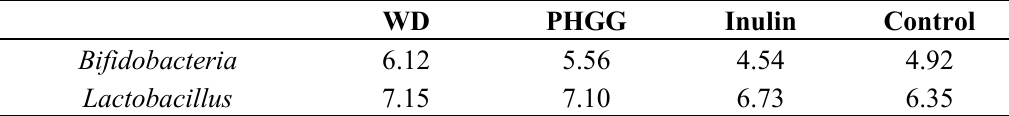
Table 3. Microbial values at 24 h